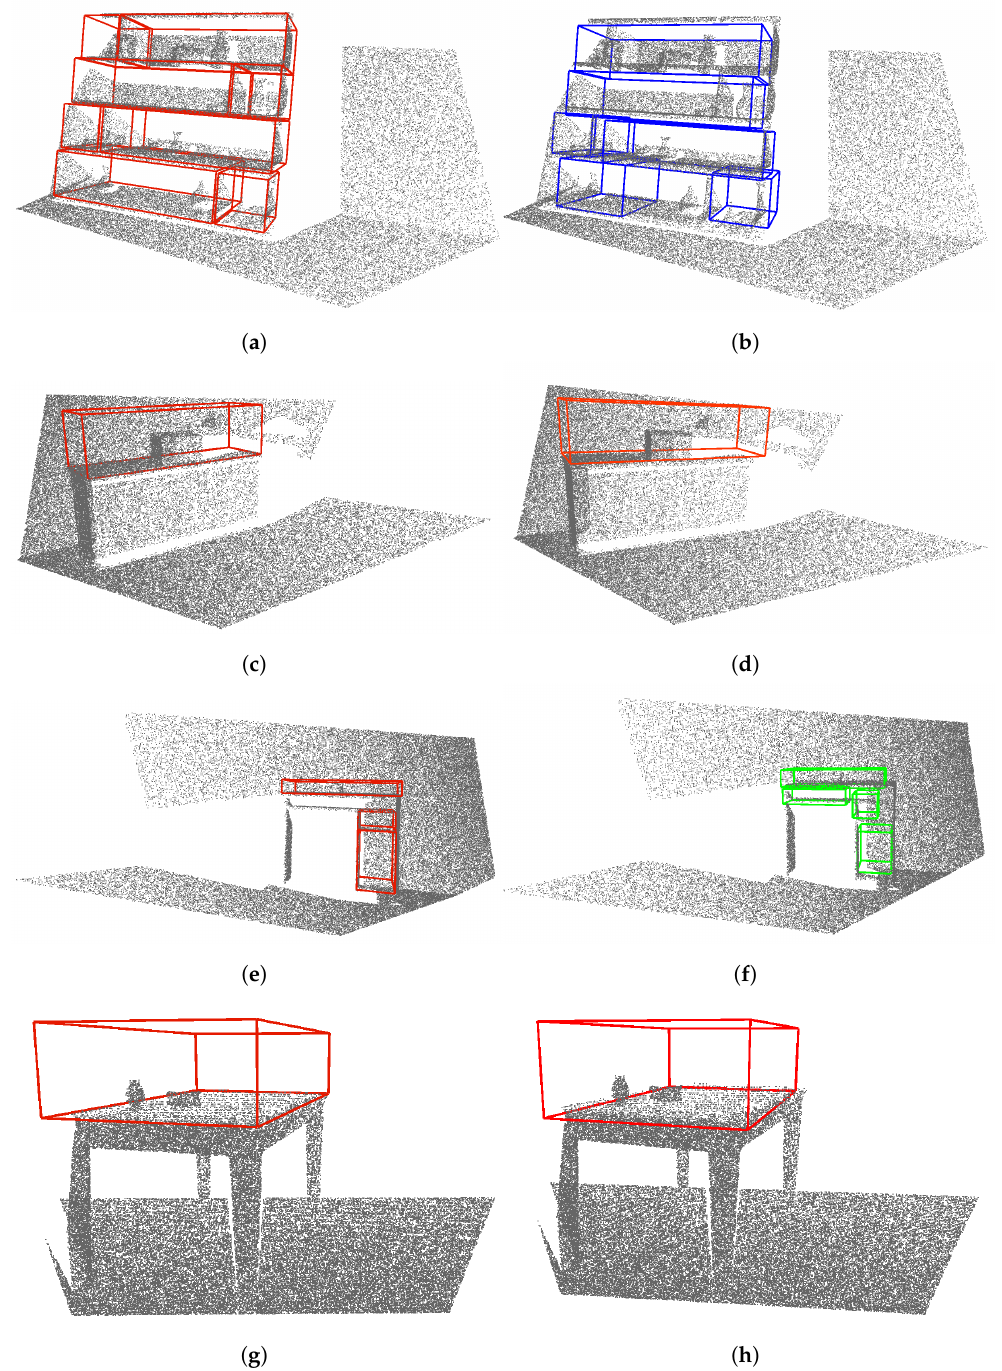
Figure 12. Examples of storage volumes in depth images for different furniture classes: ( a , b ) book- shelf, ( c , d ) cabinet, ( e , f ) desk, and ( g , h ) table. The left column shows ground truth annotation of storage volumes in the selected furniture classes. The right column shows the storage volumes predicted in these furniture models by the VoteNet